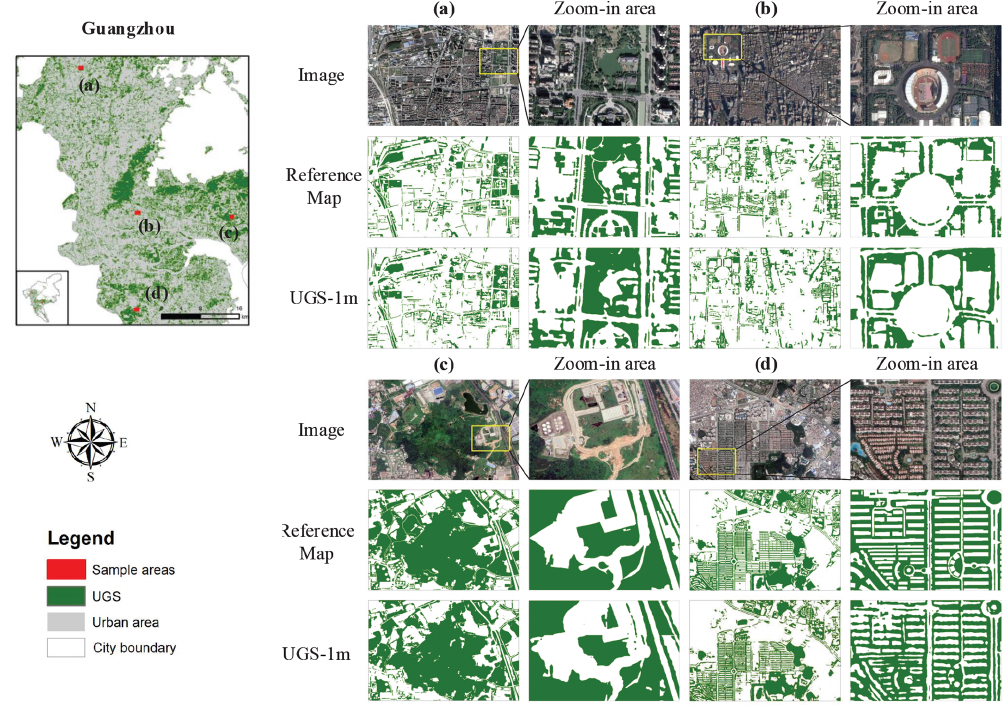
Figure 14. Qualitative analysis in UGS-1m, with a case study in Guangzhou city. Panels (a) – (d) are four example areas collected from Guangzhou. Images are from © Google Earth 2020.